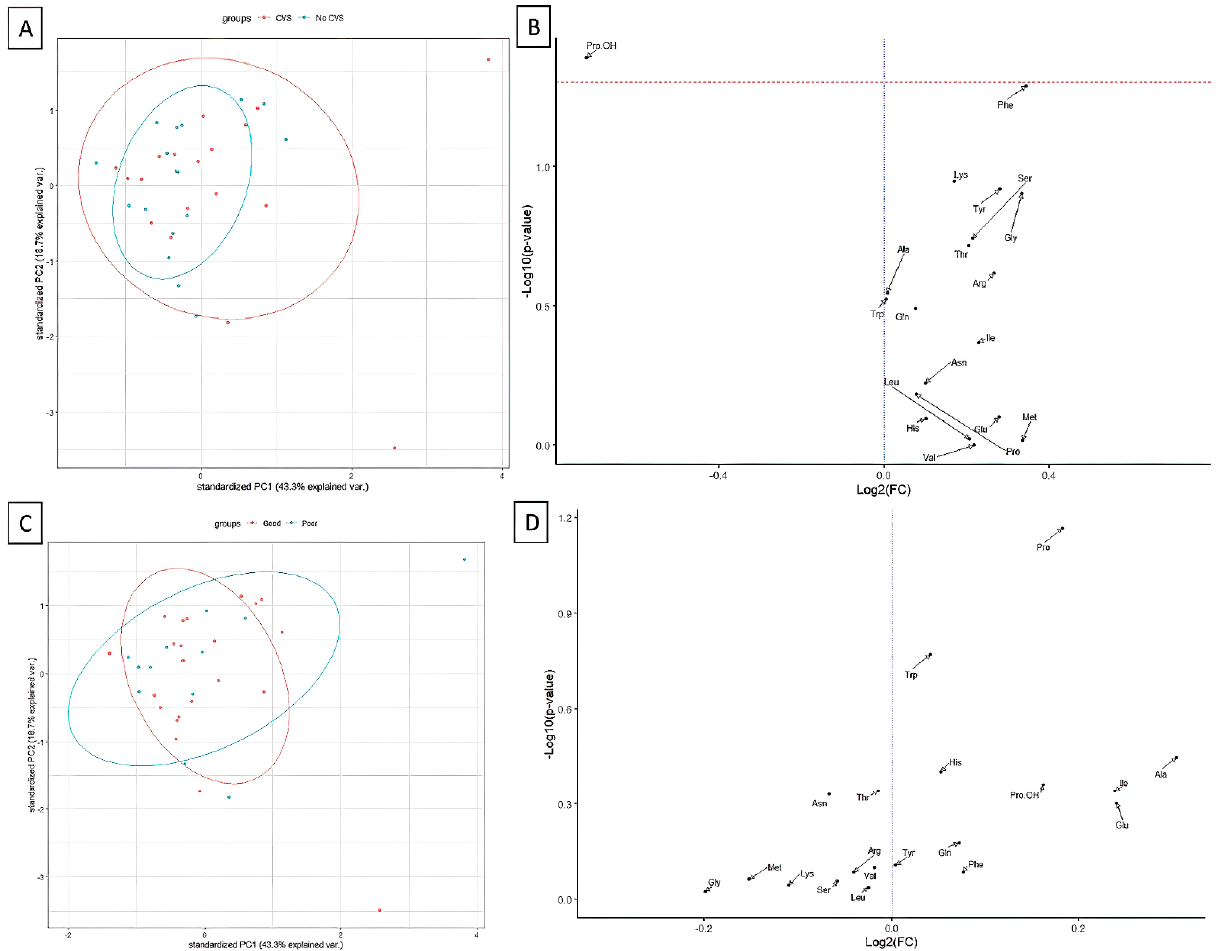
Figure 4. Principal component analysis and differential concentration analysis (volcano plots) showing the differences in amino acids concentration on postoperative day 1 between patients who developed CVS or not ( A , B ) and good or bad GOS ( C , D ). The relevant p -values are available in Table 4.